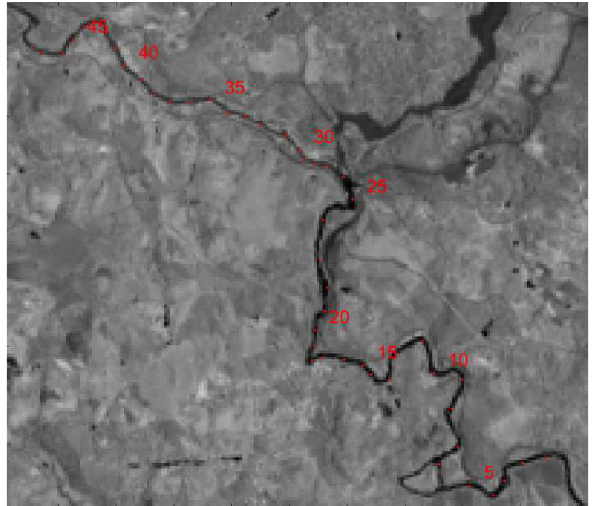
Figure 3-Location of the points where the digital values where read along the Paraopema river superposed to the near infrared image of Landsat 8/OLI.